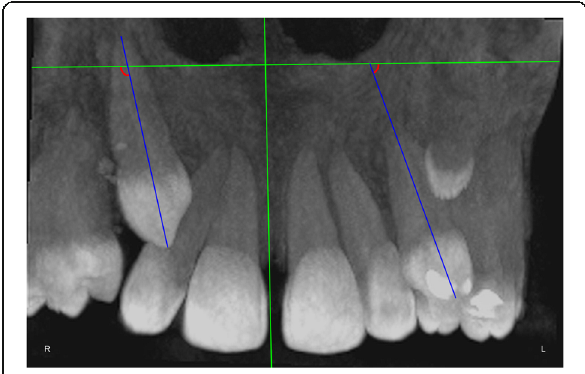
Fig. 6 Lateral angulation of long axis of canines with respect to the nasal horizontal plane. Value of the external angle of the longitudinal axis of the impacted canine and of that with no impaction with respect to the tangent of the nostril floor